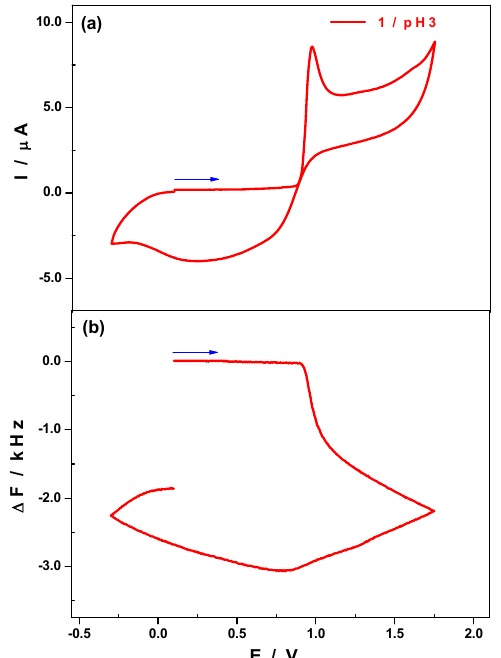
Figure 9. CV ( a ) and frequency variation as a function of the electrode potential ( b ) obtained with H 2 W 12 Mn 2 in 0.5 M Li 2 SO 4 + H 2 SO 4 /pH 3. Scan rate: 2 mV · s − 1 . Reference electrode: SCE.